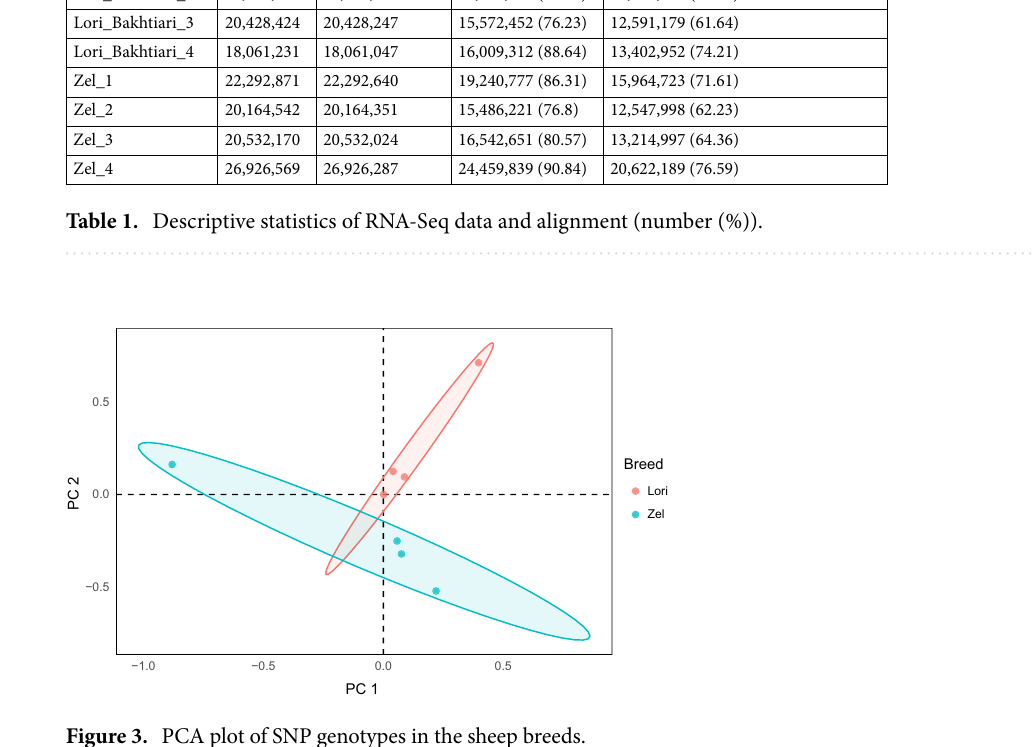
Figure 3. PCA plot of SNP genotypes in the sheep